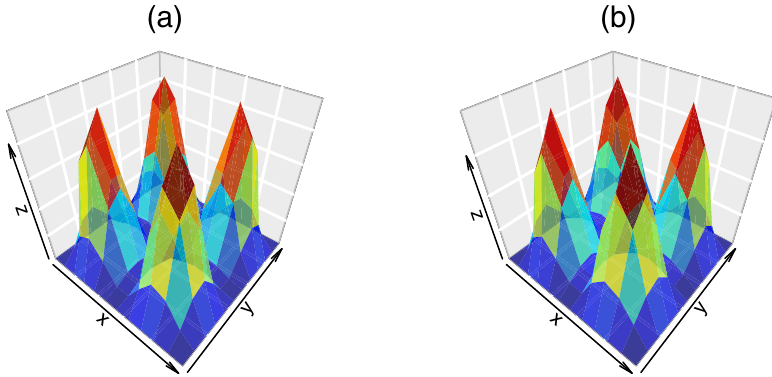
Figure 8: ( a ) is a representation of ( × 12 12 grid of points. ( b ) is an estimate of f , using f NMPQ , for